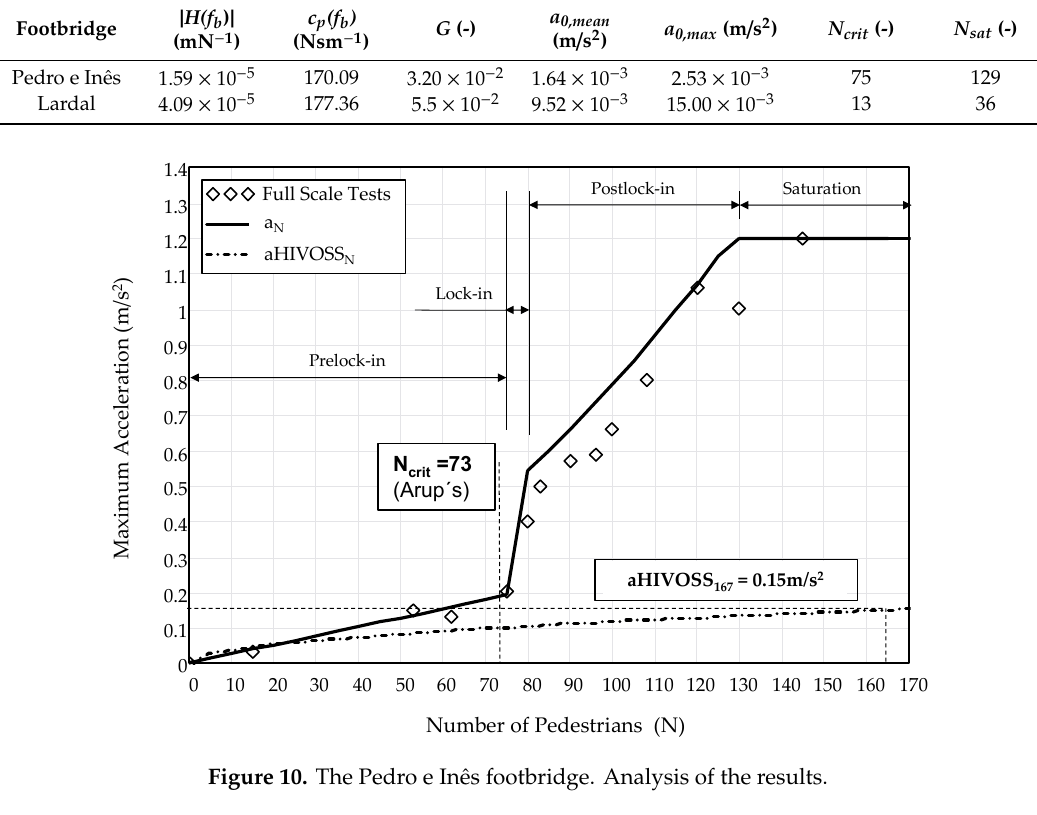
Figure 10. The Pedro e Inês footbridge. Analysis of the results.